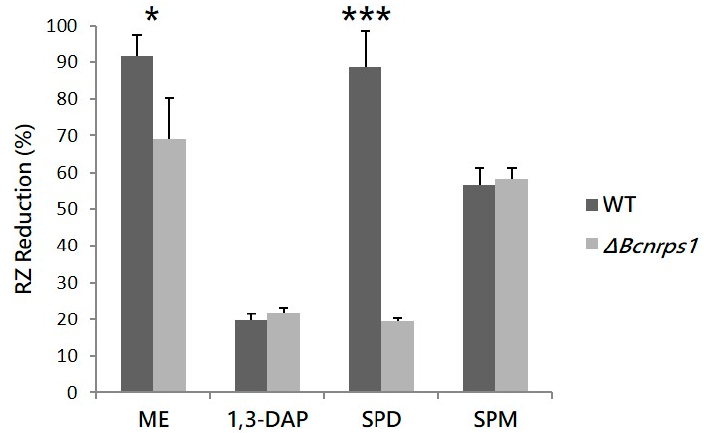
Figure 4. RZ reduction (%) due to the metabolic activity of the WT strain (gray) and the ∆ Bcnrps 1 mutant (light gray) 12 h post inoculation. ME: RZ reduction (%) in the positive control (0.2% ME medium); 1,3-DAP, SPD and SPM: RZ reduction (%) in ME medium amended with 1.5 mM, 10 μ M and 350 μ M of each PA, respectively. Error bars represent standard deviations of means ( n = 3). Asterisks indicate significant differences between strains (WT and ∆ Bcnrps 1) when grown in medium supplemented with or without PAs, according to two-way ANOVA, post hoc Tukey ′ s HSD test for factors strain and media type ( p -value < 0.05, *; p -value < 0.001, ***).